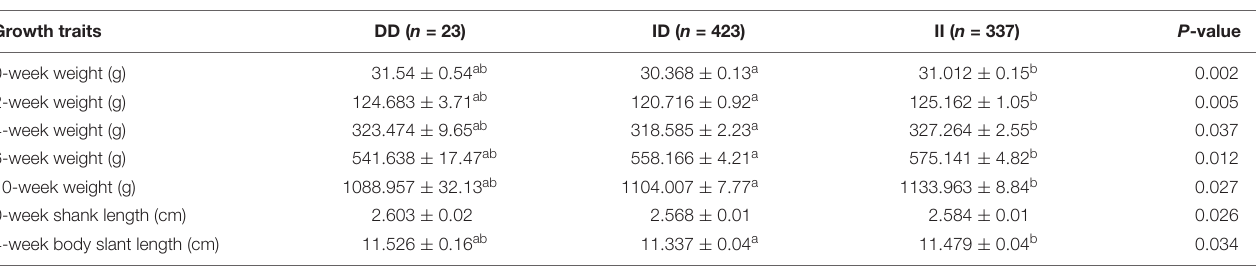
TABLE 3 | Association of the 104-bp locus with growth traits in an F 2 population at 84 days of age. Growth traits DD ( n = 23) ID ( n = 423)